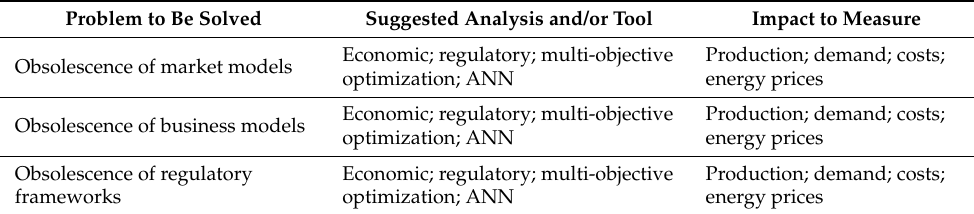
Table 11. Problems, suggestions, and impacts of market, regulation, and business models. Source: own